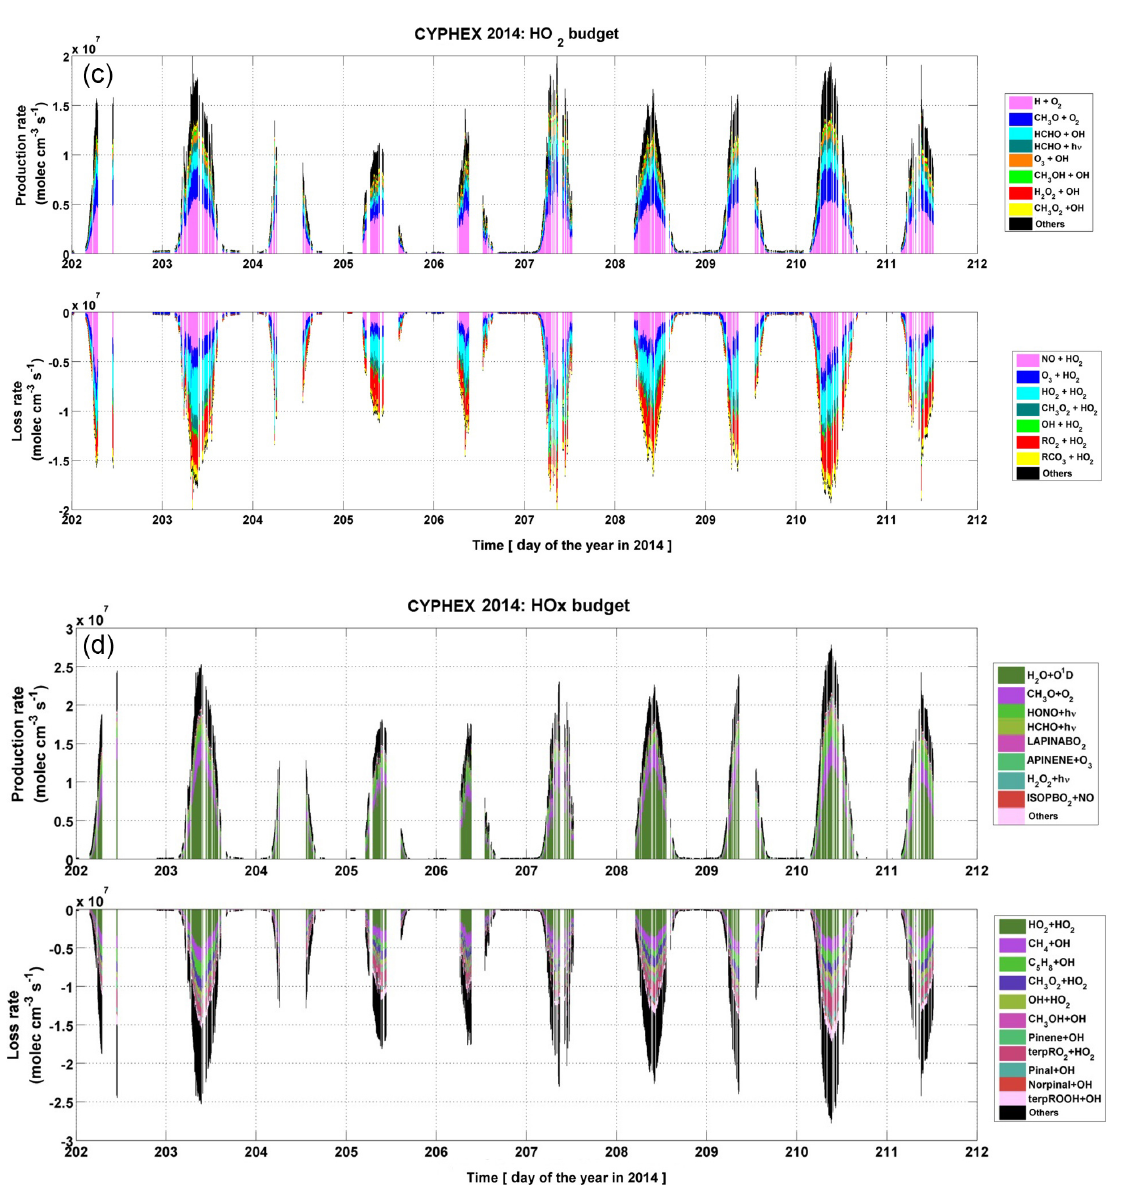
Figure 7. (c) Budget analysis for HO 2 and (d) budget analysis for HO x , during CYPHEX. The descriptions for pinene, terpRO 2 , and terpROOH are the same as in Fig.